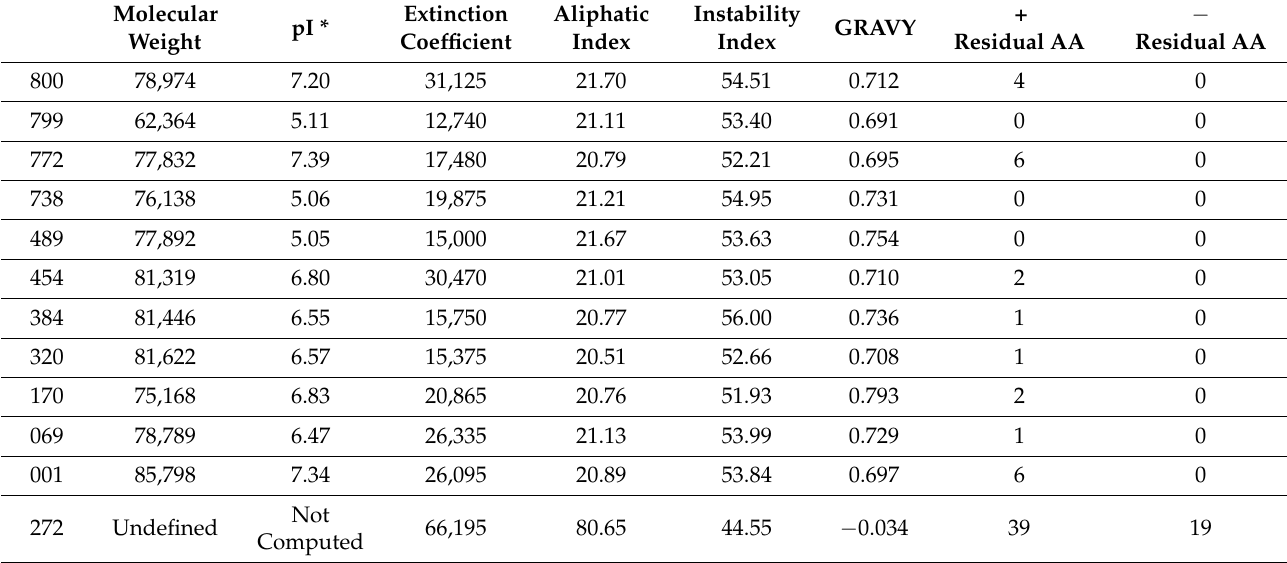
Table 4. Molecular weight, theoretical isoelectric point (pI), extinction coefficient, aliphatic index, instability index, grand average of hydropathy (GRAVY), and total number of positive and negative residues of RT of the polymerase